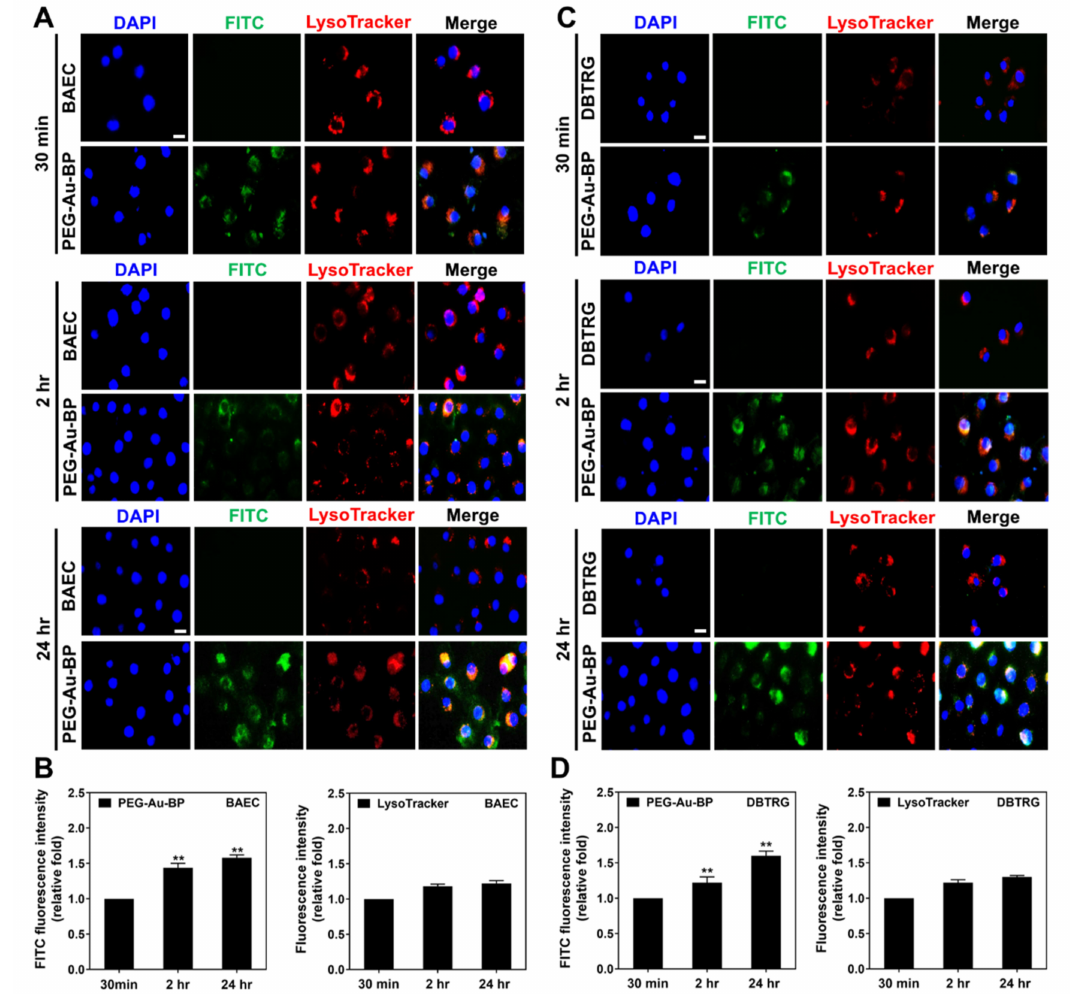
Figure 5. Inside cell transportation for PEG-Au-BP nanodrugs in BAEC and DBTRG cell lines. Lysosome is the major organelle for metabolizing foreign bodies to entry cells. Therefore, LysoTracker assay was used to detect the lysosomes (red color) for potential transportation combined with the green color fluorescence of FITC-labeled PEG-Au-BP nanoparticles, while the images of ( A ) BAEC and ( C ) DBTRG cells demonstrated the lysosomes mainly located at the perinuclear site. ( B ) Based on the quantified results from the IF method, the FITC-labeled PEG-Au-BP intensity in BAEC significantly increased at 2 h (~1.44-fold) and 24 h (~1.58-fold). ( D ) The results of DBTRG brain cancer cells also show that the FITC-labeled PEG-Au-BP uptake amount increased to ~1.22-fold at 2 h and ~1.60-fold at 24 h compared to the 30 min group. DAPI solution was used to stain cell nuclei (blue color). Scale bar equals to 10 µ m. ** p < 0.01: compared to the 30 min